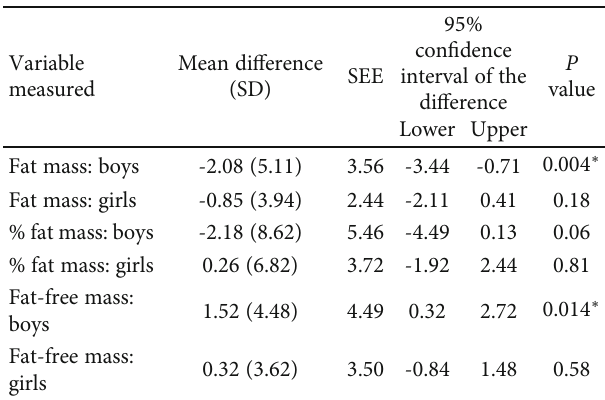
Table 3: Mean (SD) di ff erence and 95% CI between the measurements made by DXA and BIA according to